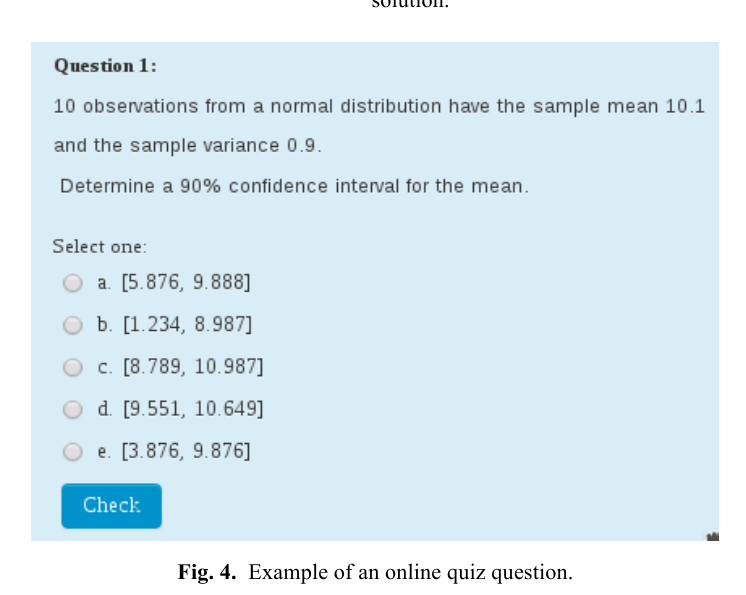
Fig. 3. Example of an exercise question with the links to the hints, the answer and the complete solution.